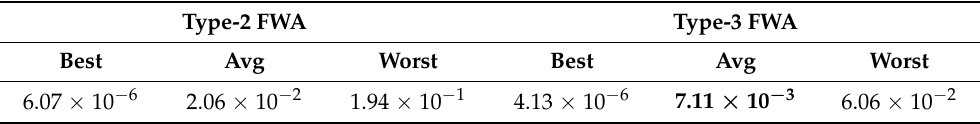
Figure 25. Future prediction (France). Table 11. First data period (future prediction, France).